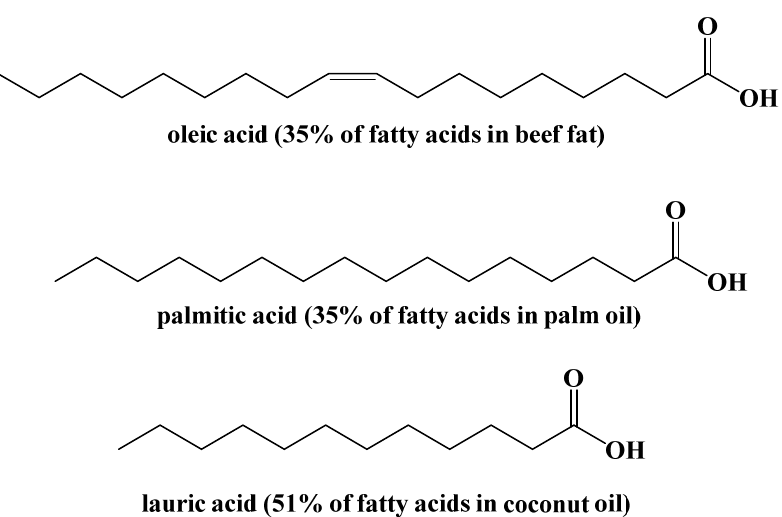
Figure 7. Major Fatty Acids in Common Foods.